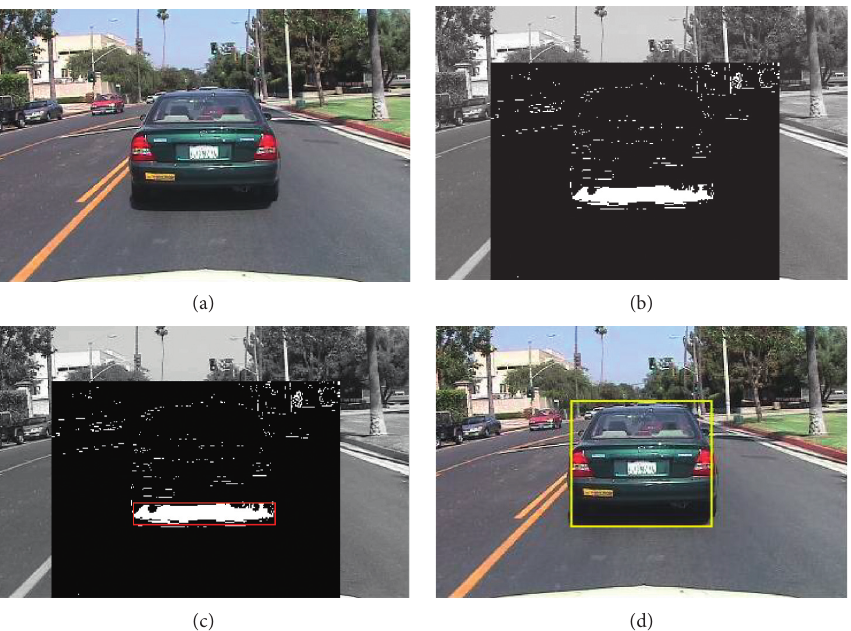
Figure 9: The extraction results of vehicle interest region based on the shadow feature. (a) The original image. (b) Shadow extraction results. (c) The interest region extracted by the shadow. (d) Vehicle detection and marking results based on the shadow